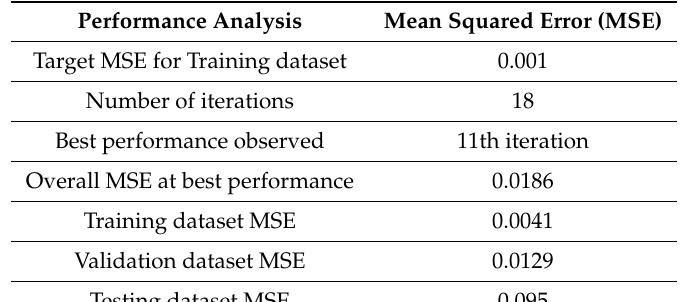
Table 4. Mean Squared Error Results.